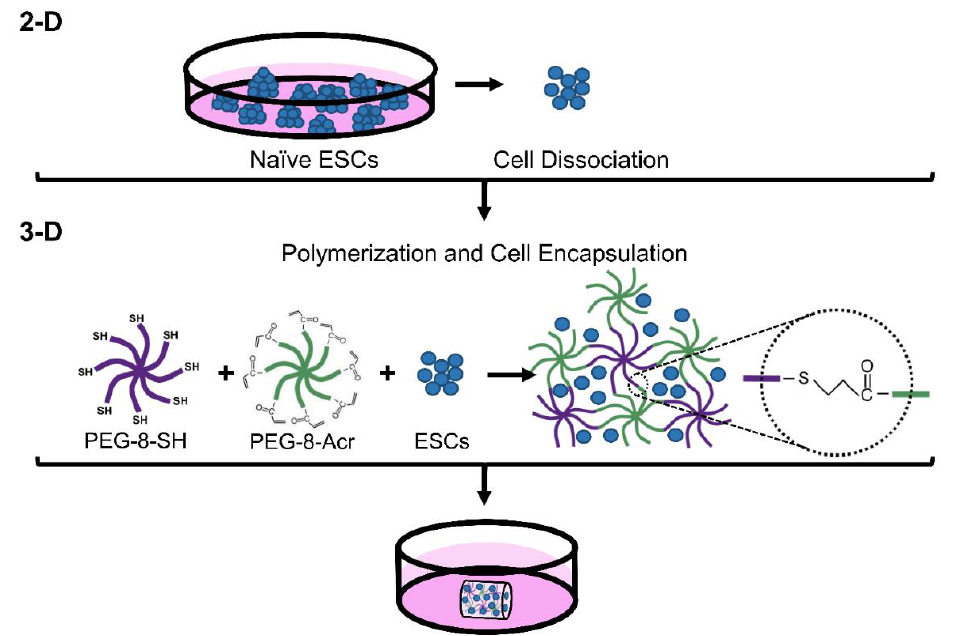
Figure 1. Encapsulation and 3-D culture of naïve human embryonic stem cells (ESCs) in self-assembling scaffolds. Elf1 cells grown in 2-D culture conditions were dissociated into single cells and mixed with self-assembling end-functionalized polymers, polymers functionalized with thiol (PEG-8-SH) and acrylate (PEG-8-Acr). The polymer/cell mixture was then transferred to a syringe mold and allowed to form 3-D scaffolds, encapsulating the cells. The scaffolds were then transferred to 24-well plates containing culture medium.